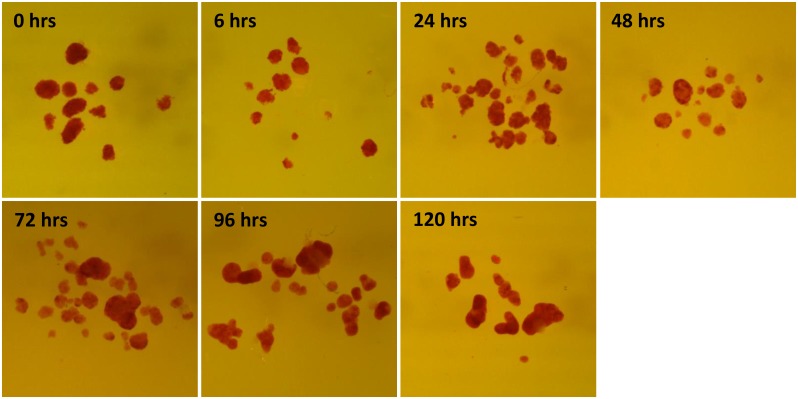
Dithizone staining of islets cultivated for different time periods.Magnification 15×.